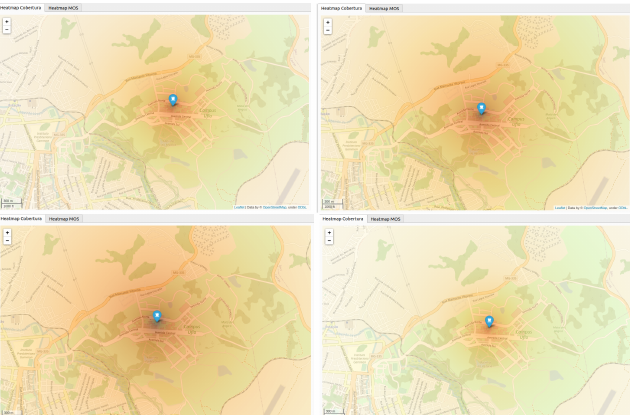
Figure 8. Signal strength results of an RBS located in MG state according to a developed software of operators 1, 2, 3, and 4, in which the map on the left of the first row represents operator 1, the map on the left in the second row represents operator 3. the map on the right of the first row represents operator 2, the map on the right in the second row represents operator 4.